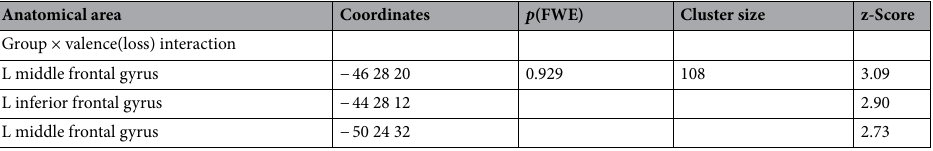
Table 2. EEG-fMRI coupling (theta-associated activations). Significance level: p < 0.005 (uncorr.) and cluster extent k ≥ 100. EEG electroencephalography, fMRI functional magnetic resonance imaging, FWE family-wise error rate, L